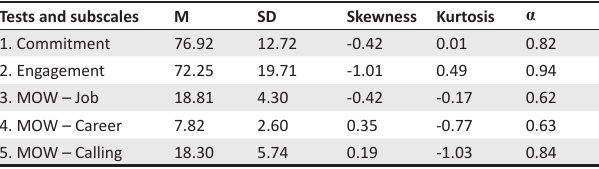
TABLE 1: Descriptive statistics and Cronbach’s alpha coefficients of the measuring instruments. Tests and subscales M SD Skewness Kurtosis α